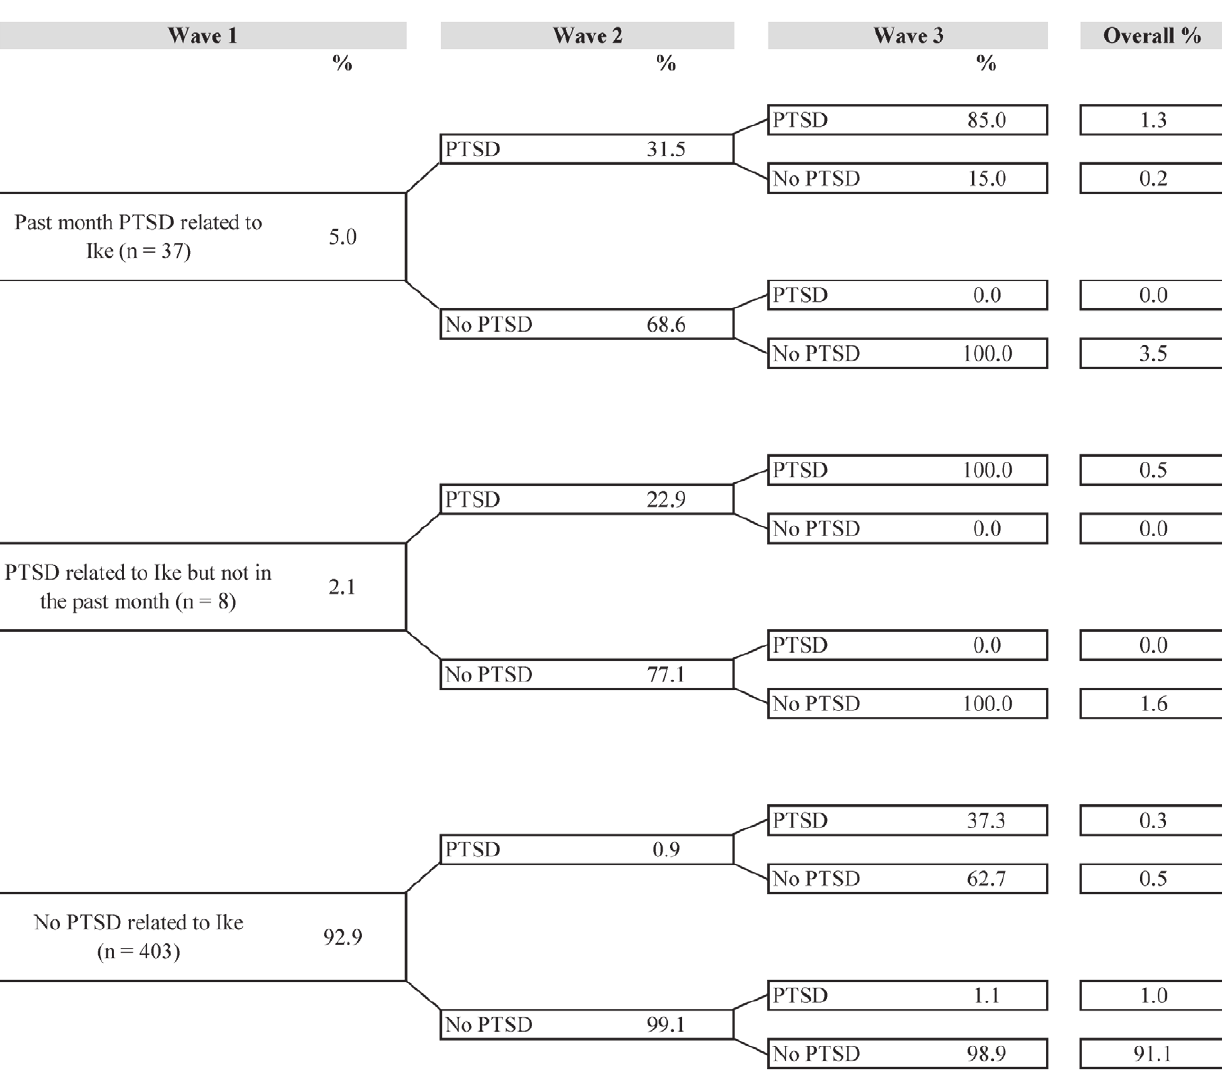
Figure 1. Trajectories of Ike-related PTSD (n=448).